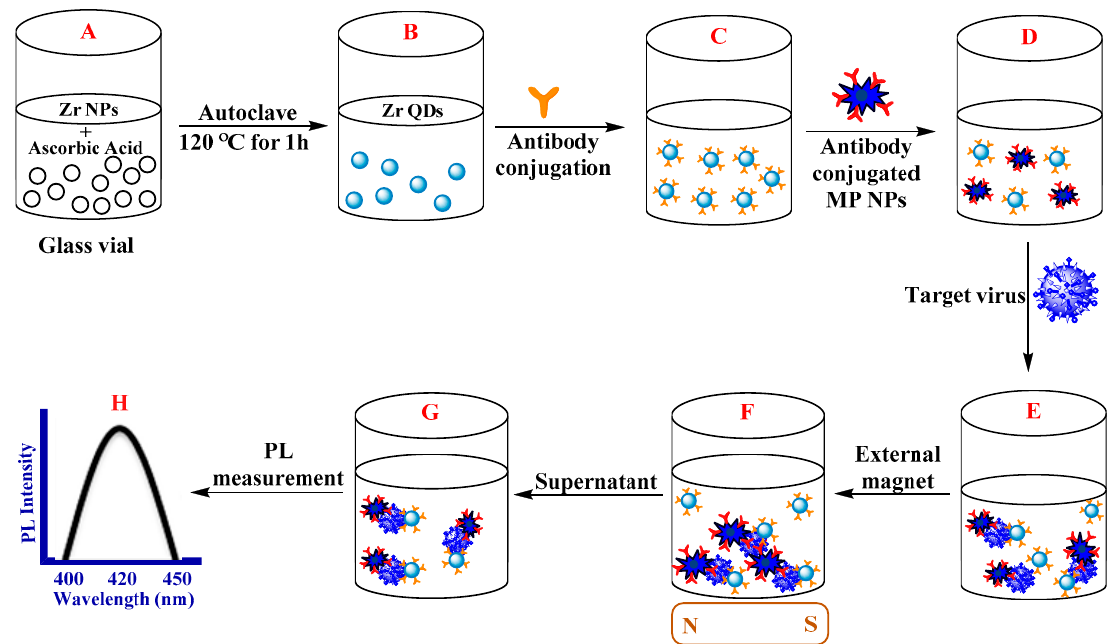
Figure 9. Biosensor design representation: ( A ) zirconium (Zr) NPs and CoV under reducing agent; ( B ) Zr QDs preparation; ( C ) the Ab linked QDs; ( D ) adding Ab-conjugated magneto-plasmonic (MP) NPs; ( E ) the generation of nanostructured MP fluorescent with the target’s addition and subsequent separation process ( F ); ( G ) dispersion of the nanohybrid-conjugated part and the following measurement of the optical characteristics (PL: photoluminescence) ( H ). Redrawn with permission from [53] .